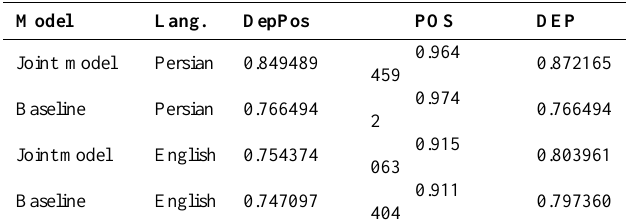
Table 4. Model First Result for CPOS.